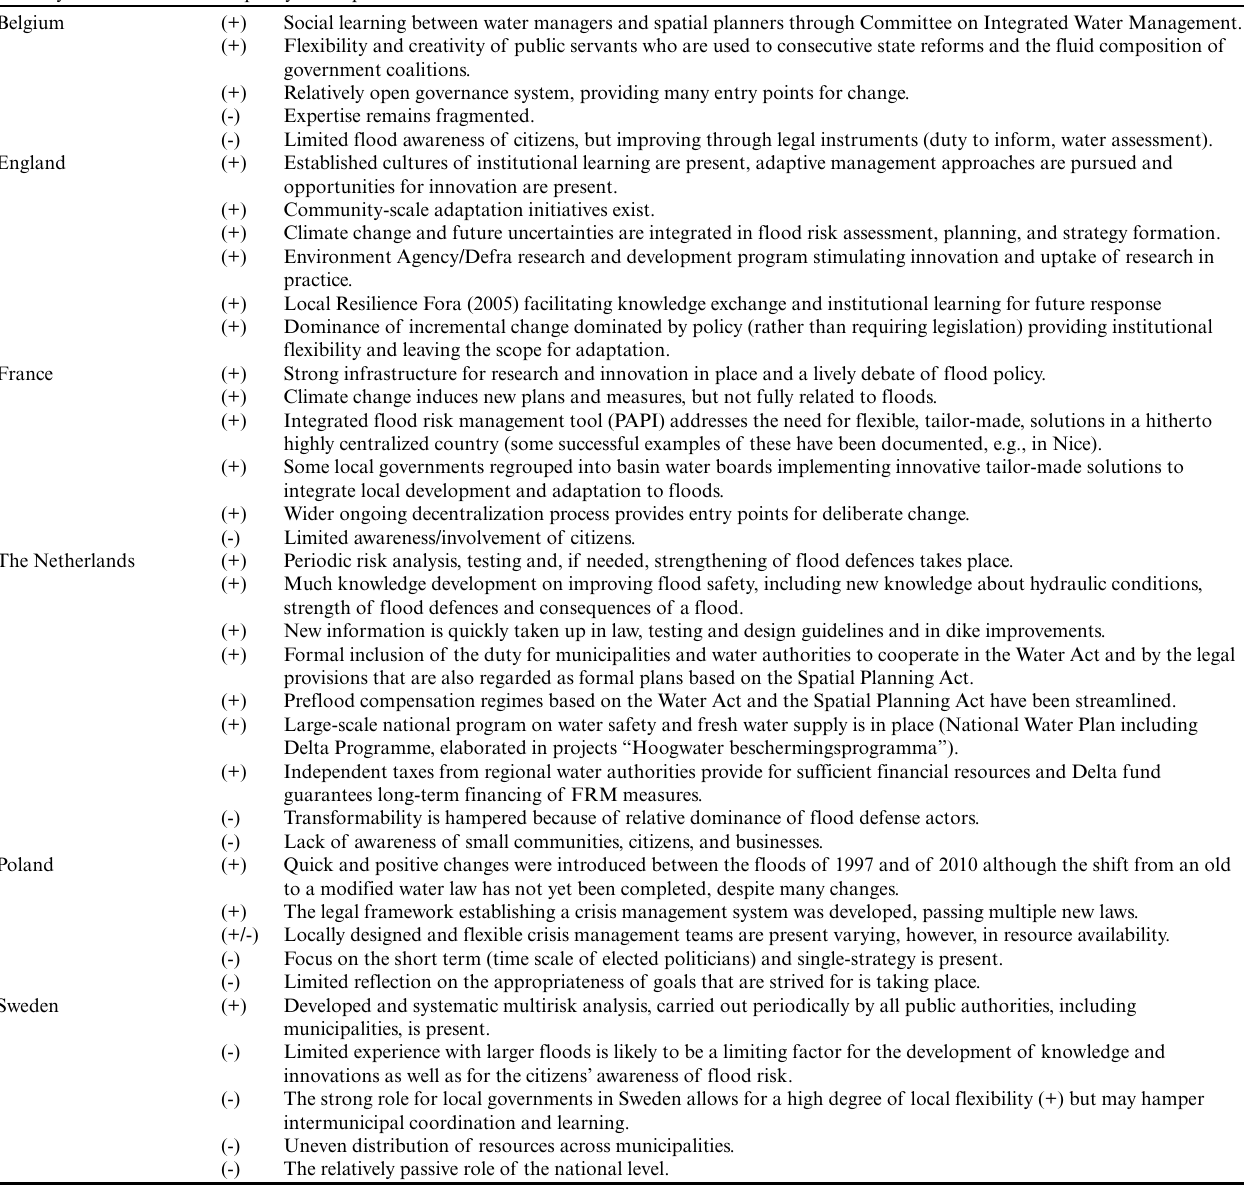
Table 6 . Capacity to transform and adapt in the six evaluated